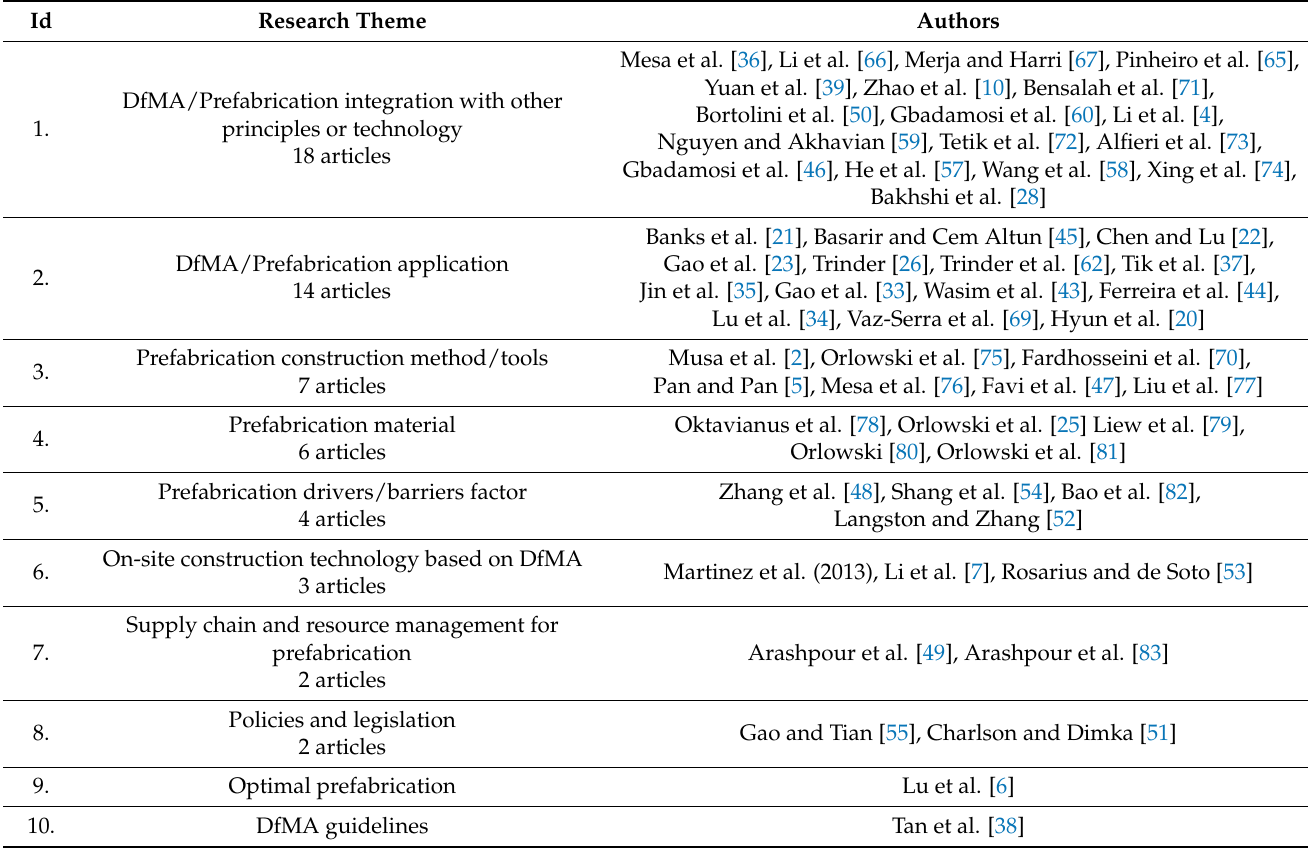
Table 5. Summary of research themes related to